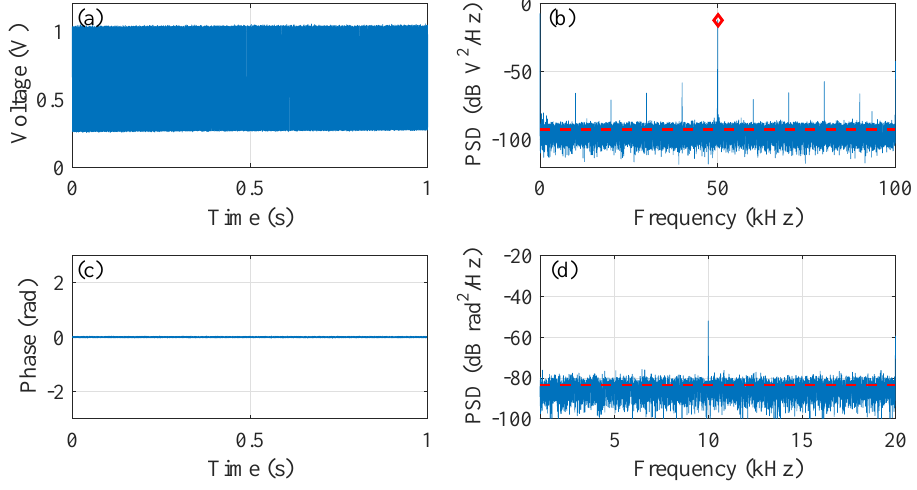
Figure 4. Results for channel 163 (low noise channel). ( a ) the detected intensity signal; ( b ) the PSD